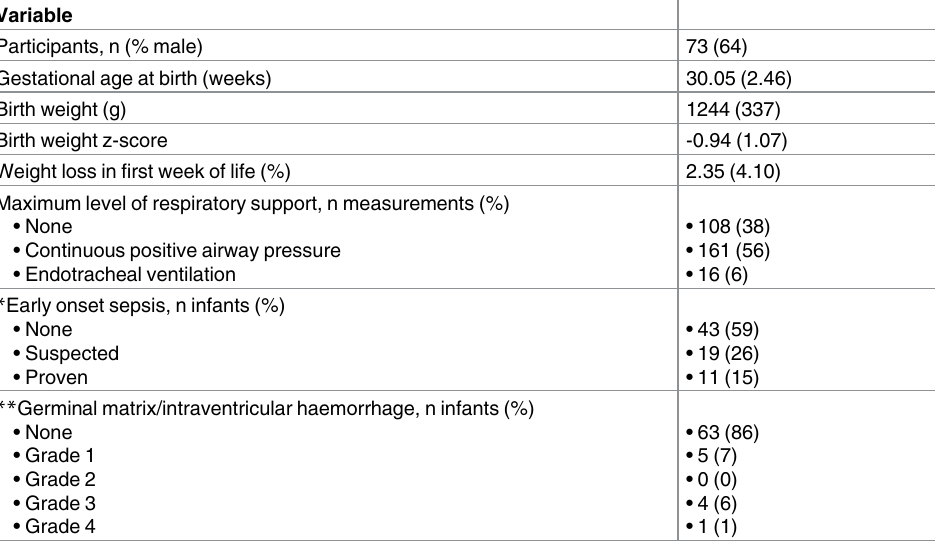
Table 1. Baseline characteristics of study